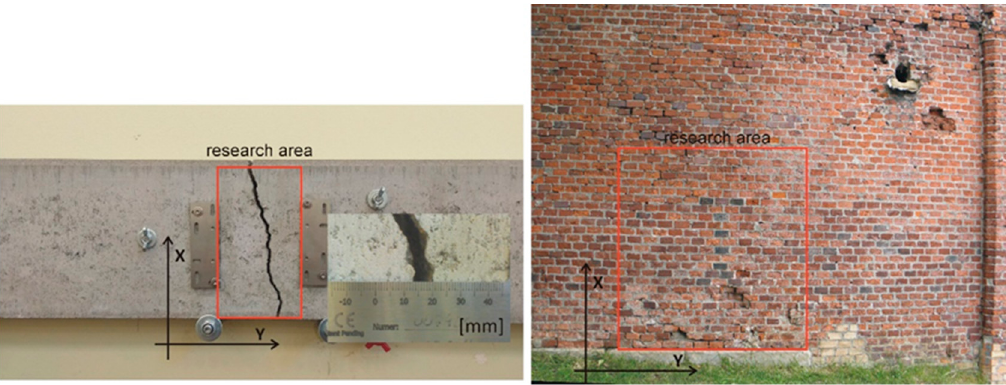
Figure. 4. The research objects: concrete sample (on the left) and brick wall of the citadel (on the right).